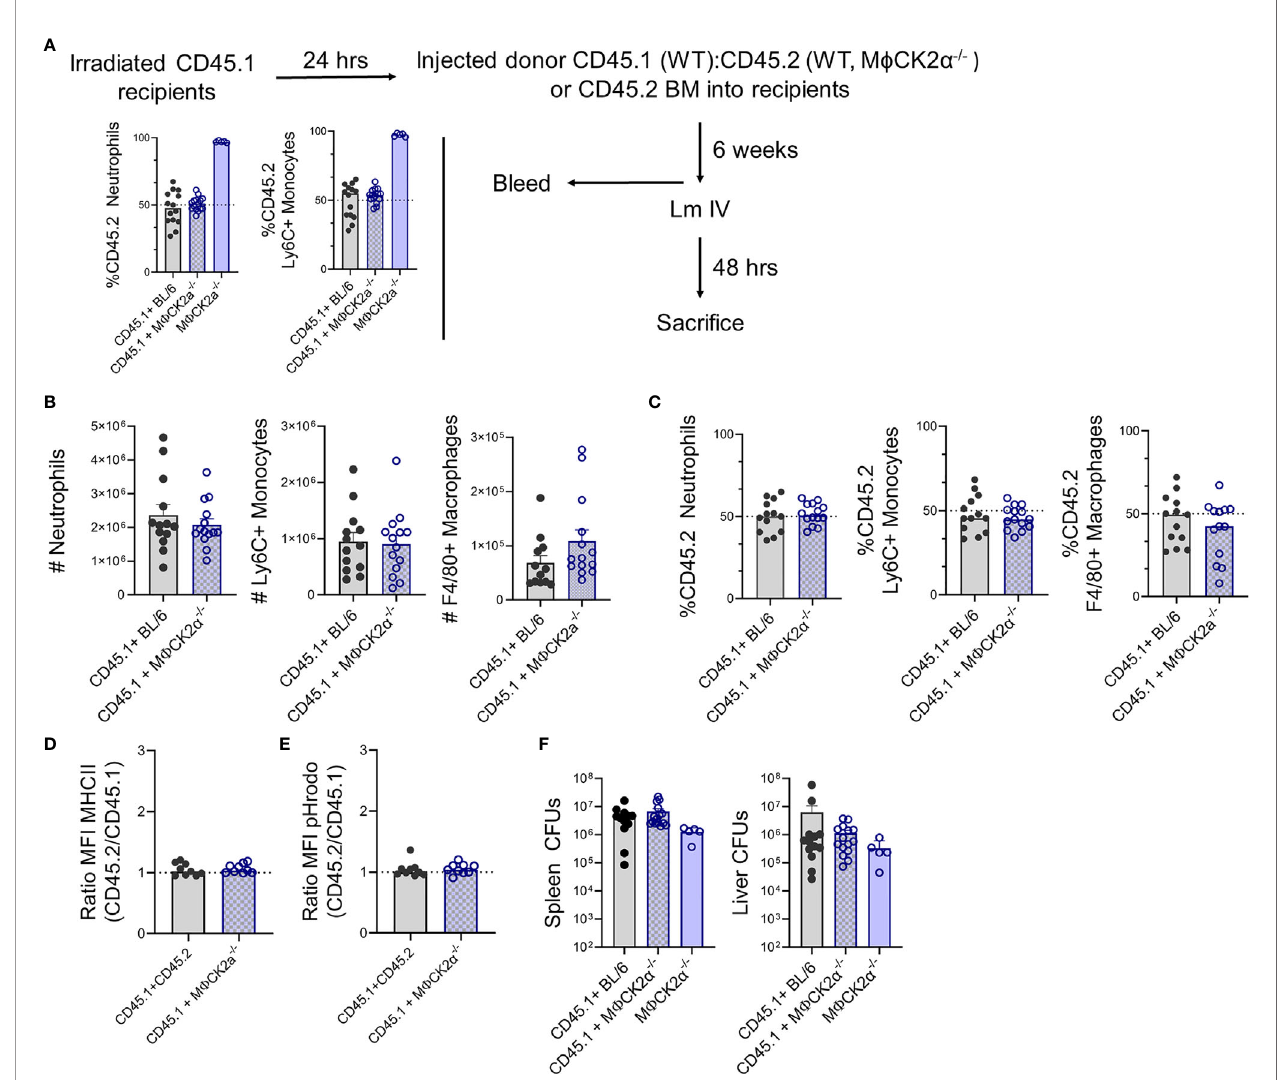
FIGURE 4 | CK2 a suppresses myeloid cell accumulation for increased Lm burdens in trans . Bone marrow (BM) chimera experiments. (A) Schematic of experiment and graphs summarizing % of CD45.2 neutrophils and Ly6C+ monocytes in blood of irradiated CD45.1 recipients at 6 weeks after reconstitution with 1:1 mixtures of WT CD45.1 plus CD45.2 WT or M f CK2 a − / − BM cells. The proportion of CD45.2+ cells is also shown for mice reconstituted with only CD45.2 M f CK2 a − / − donor cells. (B – E) Splenocytes were harvested from Lm infected CD45.1+BL/6 and CD45.1+ M f CK2 a − / − chimeras 2 dpi. (B) Total numbers of neutrophils, Ly6C+ monocytes, and F4/80+ macrophages in the mixed chimeras were enumerated by cell counts and fl ow cytometry. (C) Proportions of CD45.2+ neutrophils, Ly6C+ monocytes, and F4/80+ macrophages in the infected mixed chimeric animals. Surface expression of (D) MHCII and (E) fl uorescence of pHrodo at 1 h after uptake were compared between CD45.1+ and CD45.2+ Ly6C+ monocytes from chimeric mice. Shown are ratios of the MFI for each marker in the CD45.2 vs CD45.1 cells. (F) Bacteria burdens (CFUs) in livers and spleens of the respective chimeric animals at 2 dpi with Lm. Figure panels (A , F) show data pooled from three experiments with four to fi ve mice/group/experiment, a group of mice received only CD45.2 M f CK2 a − / − BM cells in the third experiment. Figure panels (B – E) are data pooled from three experiments, eight to ten